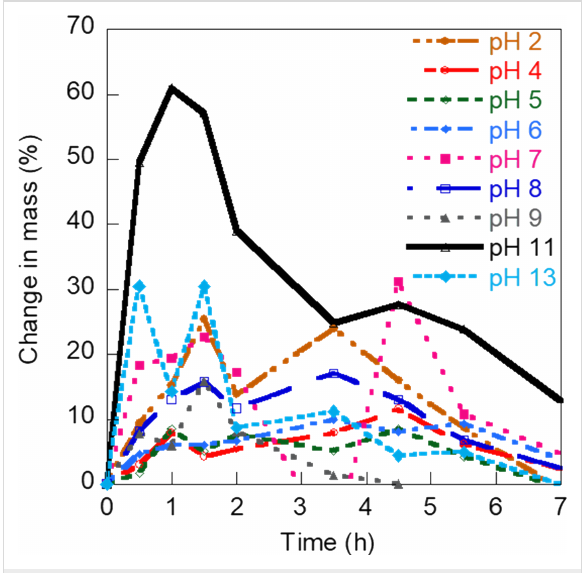
Figure 2: Plot showing pH-dependent swelling behavior of the pHEMA hydrogel prepared with 1.3 mL DI water over a period of 7